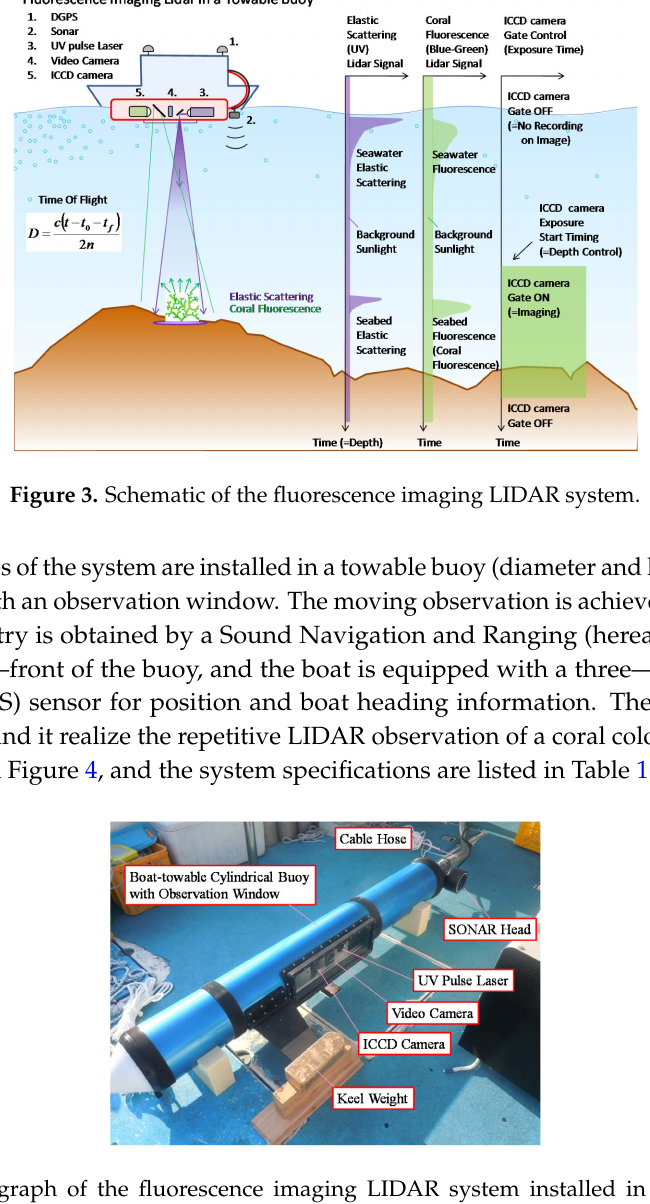
Figure 4. Photograph of the fluorescence imaging LIDAR system installed in a boat—towable cylindrical buoy with an underwater observational